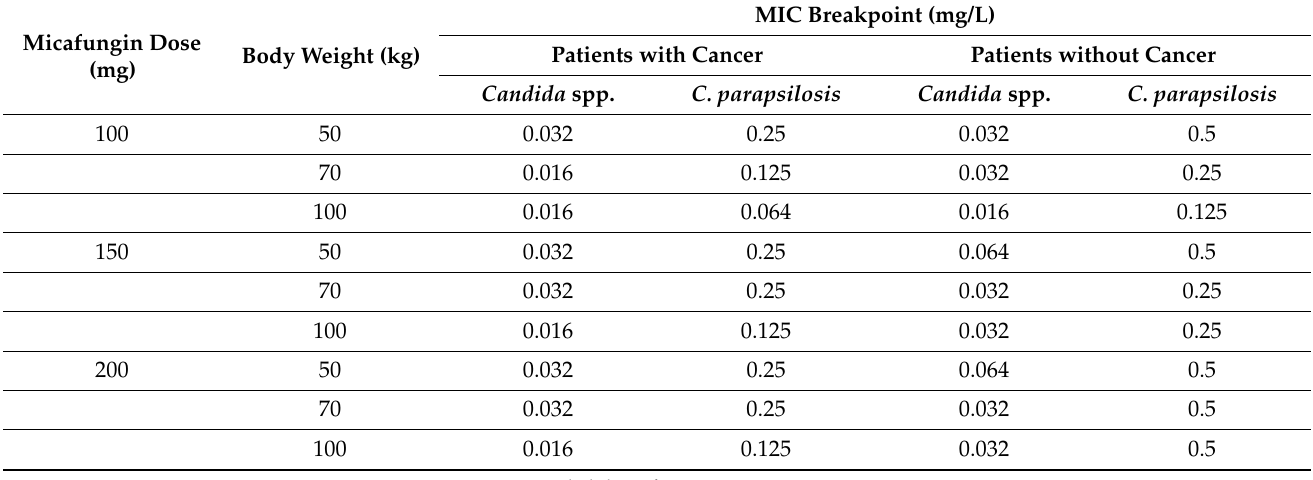
Table 3. MIC breakpoints for Candida spp. and C. parapsilosis indicating 90% PTA for various micafungin doses in patients weighing 50, 70, and 100 kg.